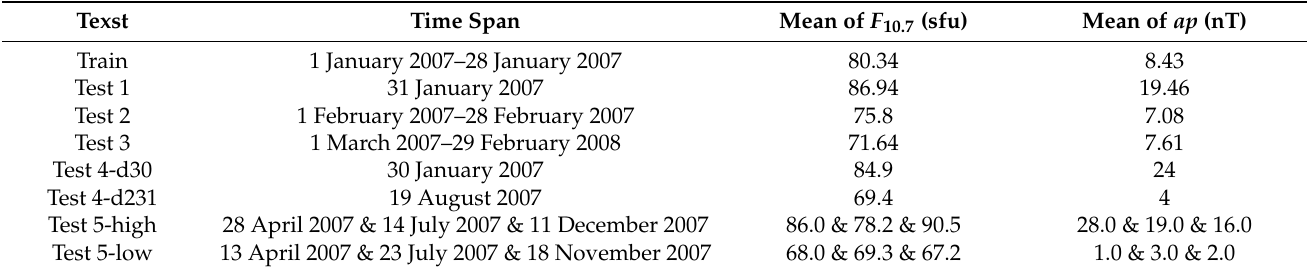
Table 1. The mean of solar radio flux ( F 10.7 ) and geomagnetic index (ap) in different time span. Time